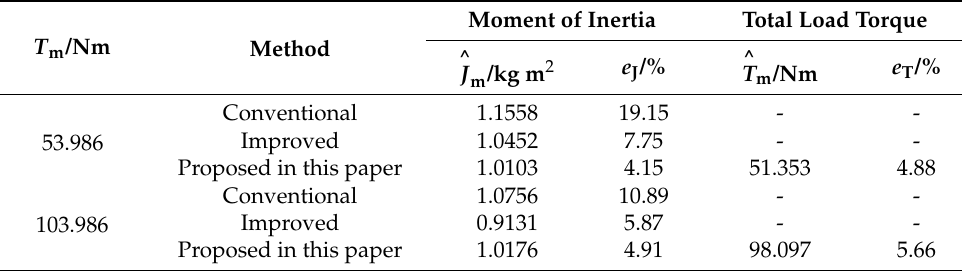
Table 4. Comparison of the experimental results of the identification value and identification